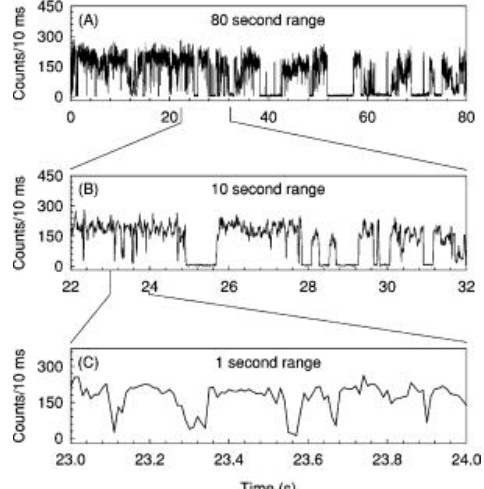
Figure 10. Blinking effect during luminescence from a single 2.9 nm sized CdSe Qdot (reprinted with permission from [121]. Copyright 2000, American Institute of